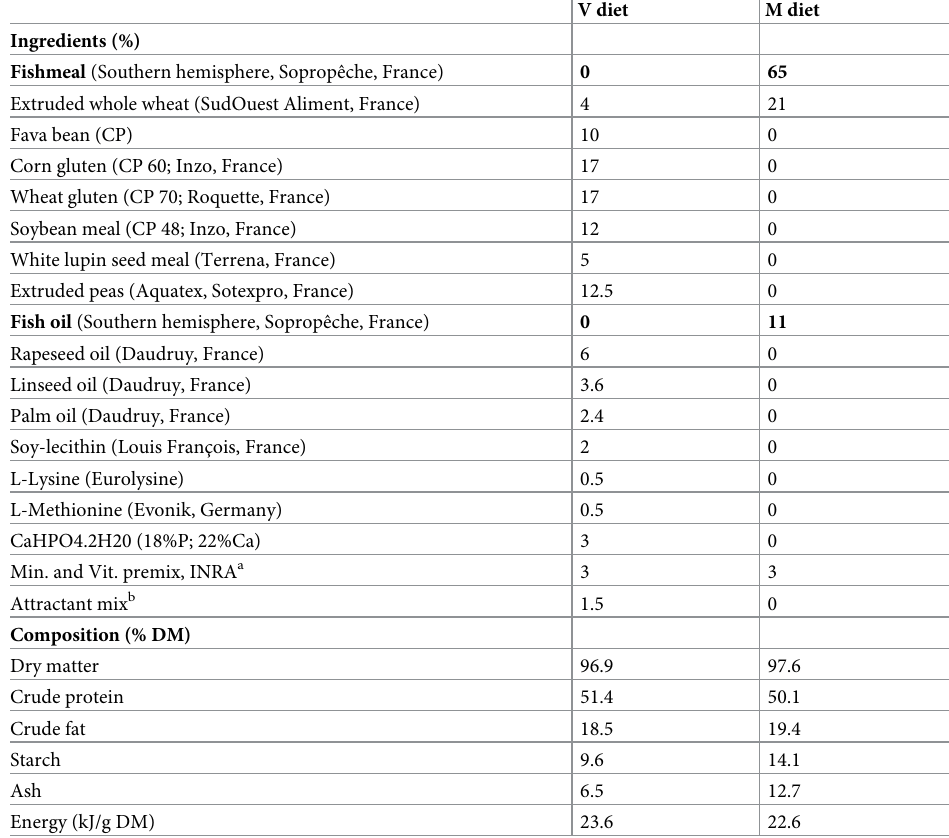
a Mineral premix (g or mg kg-1 diet): calcium carbonate (40% Ca), 2.15 g; magnesium oxide (60%Mg), 1.24 g; ferric citrate, 0.2 g; potassium iodide (75%I), 0.4 mg; zinc sulphate (36%Zn), 0.4 g; copper sulphate (25%Cu), 0.3 g; manganese sulphate (33%Mn), 0.3 g; dibasic calcium phosphate (20%Ca, 18%P), 5 g; cobalt sulphate, 2 mg; sodium selenite (30%Se), 3 mg; KCl, 0.9 g; NaCl, 0.4 g (UPAE, INRA); And Vitamin premix (IU or mg kg-1 diet): DL-a tocopherol acetate, 60 IU; sodium menadione bisulphate, 5 mg; retinyl acetate, 15,000 IU; DL-cholecalciferol, 3,000 IU; thiamin, 15 mg; riboflavin, 30 mg; pyridoxine, 15 mg; B12, 0.05 mg; nicotinic acid, 175 mg; folic acid, 500 mg; inositol, 1,000 mg; biotin, 2.5 mg; calcium pantothenate, 50 mg; choline chloride, 2,000 mg (UPAE, INRA).